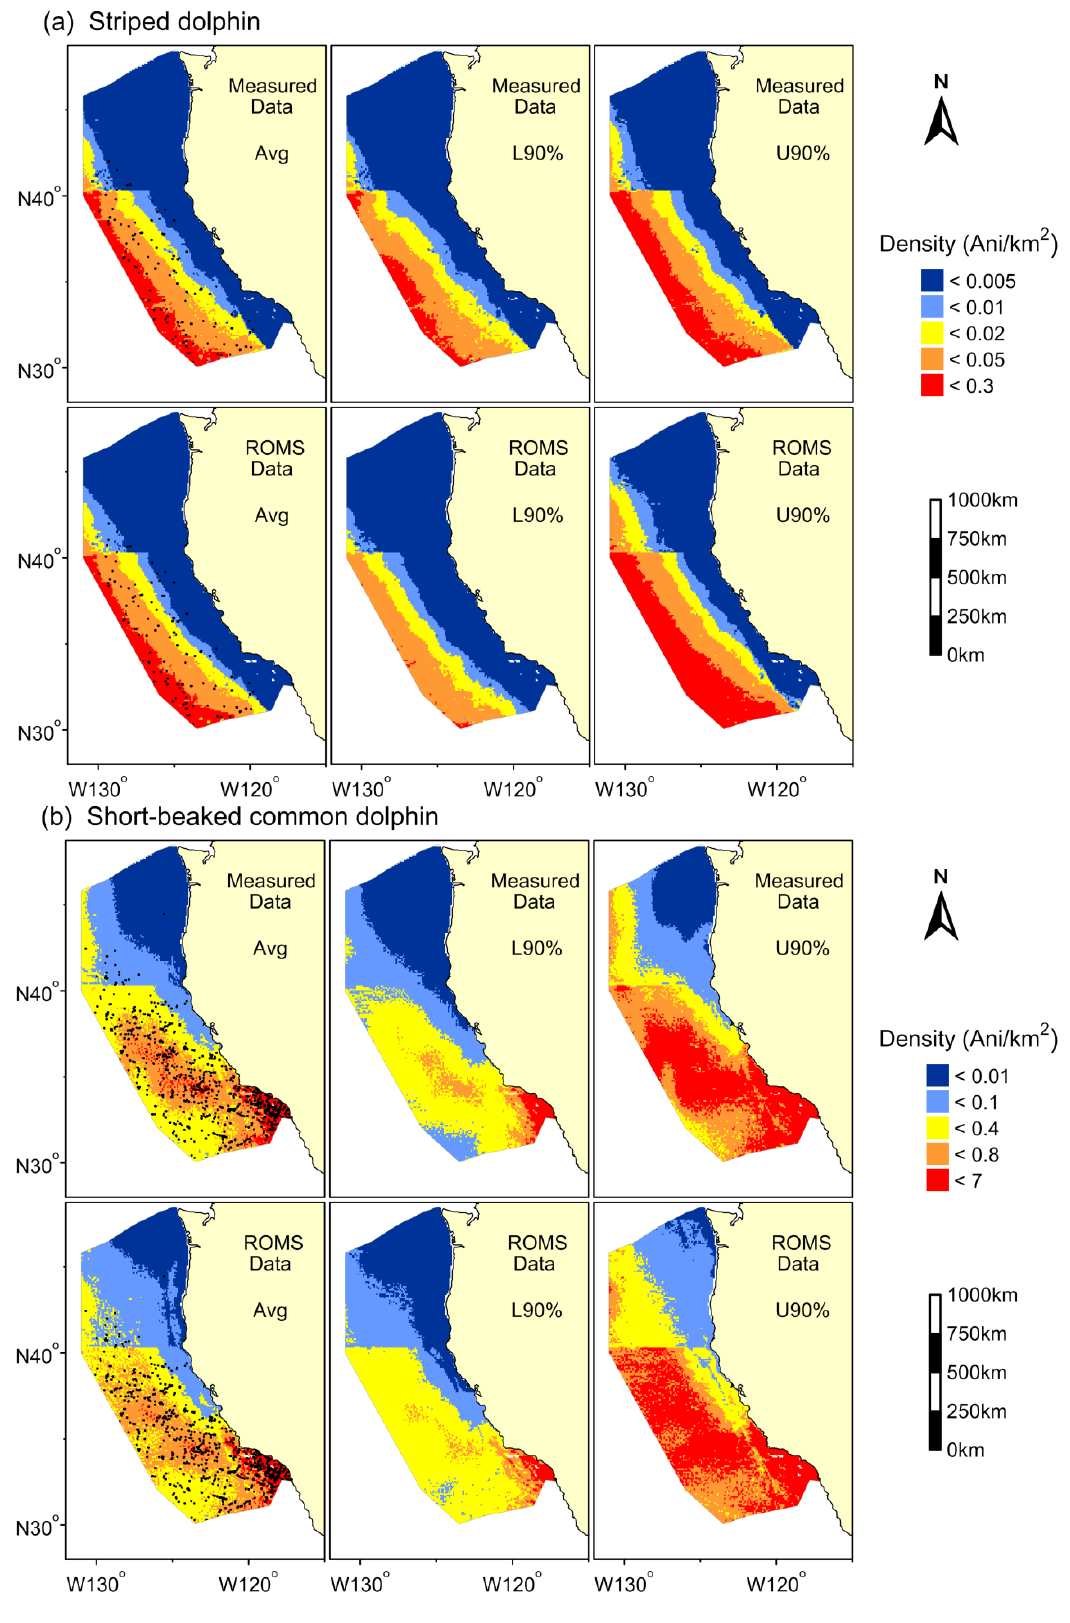
Figure 2. Cont. Figure 2.